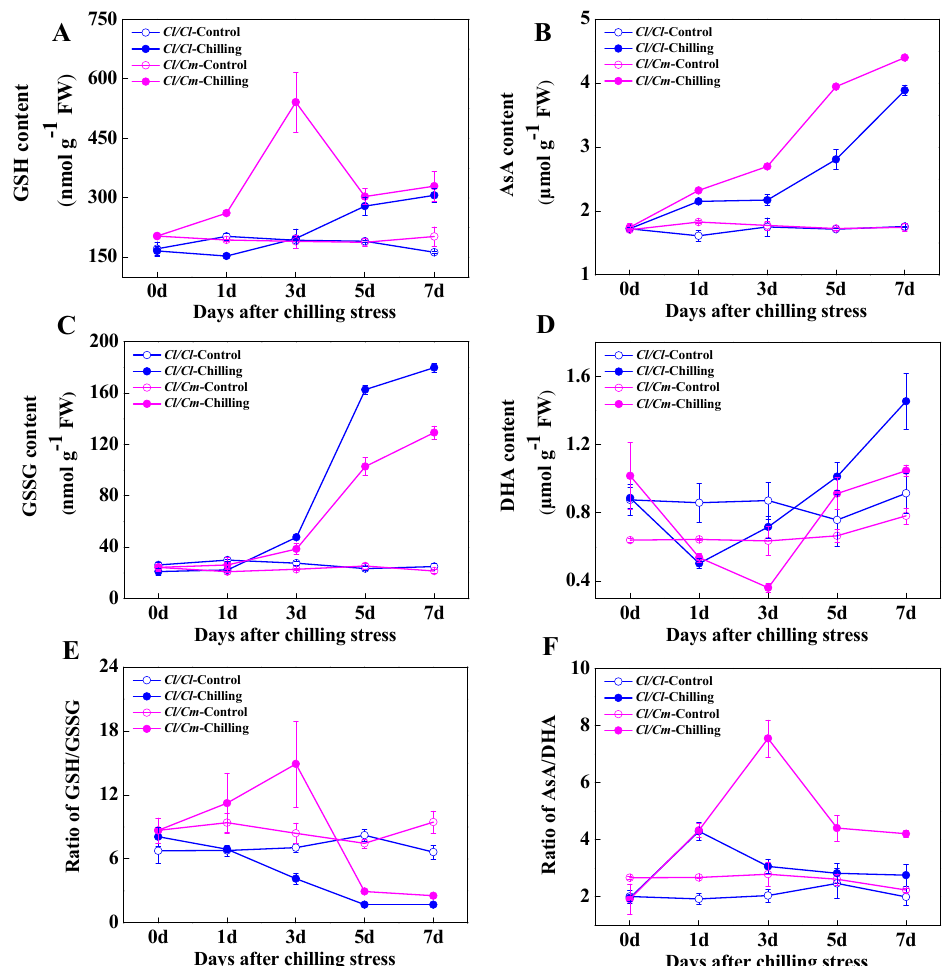
Figure 3. Chilling-induced changes in glutathione and ascorbate homeostasis in grafted watermelon leaves. ( A ) Reduced (GSH) and ( C ) Oxidized glutathione (GSSG) content. ( B ) Reduced (AsA) and ( D ) Oxidized ascorbate content. ( E ) The ratio of GSH/GSSG content. ( F ) The ratio of AsA/DHA content. Leaf samples were collected at indicated times under control (28/18 °C) and chilling (10/5 °C) conditions. Cl / Cl , self-grafted watermelon plants; Cl / Cm , pumpkin rootstock-grafted wa- termelon plants. The data are the means of four replicates with SEs. rootstock induced SA biosynthesis in the leaves and roots of grafted watermelon seedlings, and chilling induced hydrolysis of conjugated SA into free SA in the roots combined with increased accumulation of free SA in the leaves of Cl / Cm plants probably serve to improve chilling tolerance. In addition, the activity of PAL in the leaves of Cl / Cm plants was significantly higher than that in Cl / Cl plants under normal temperature (Figure 5A). Chilling induced significant increase in PAL activity in the leaves and roots of Cl / Cl and Cl / Cm plants, which showed that PAL activity in the roots of Cl / Cm plants peaked at 3 d of chilling stress in comparison with control (Figure 5).